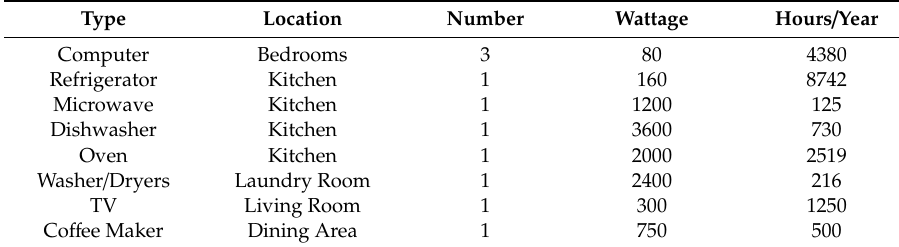
Table 6. Plug loads and equipment.